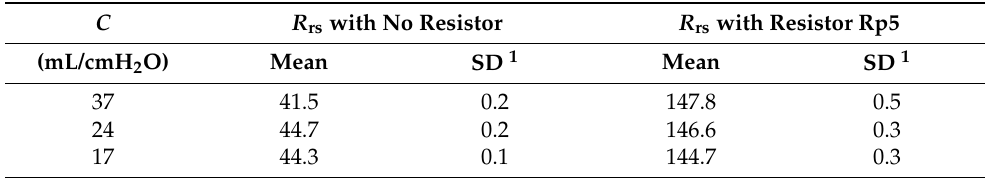
and 1.8% with the resistor.